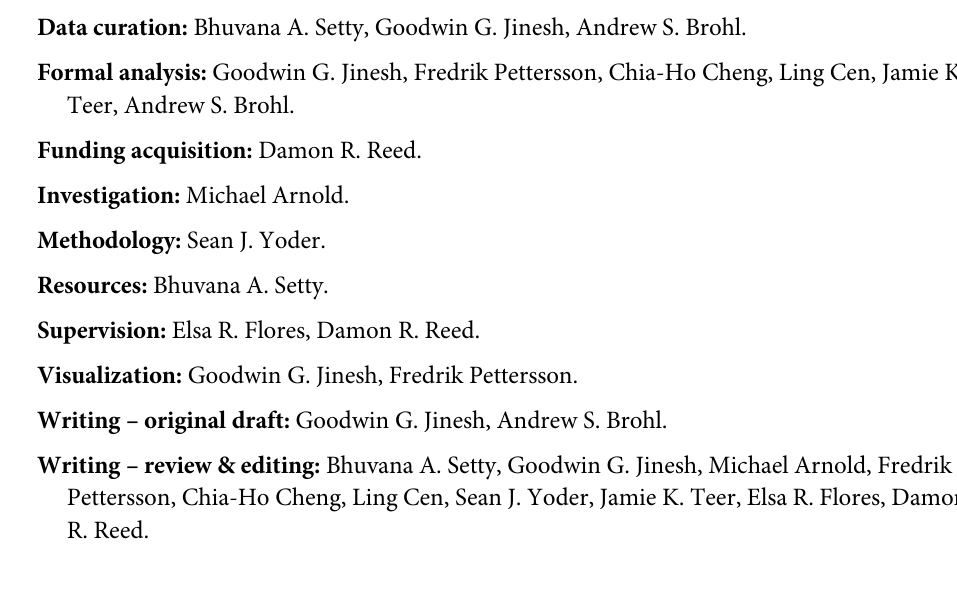
S2 Fig. Proposed multistep genomic development of UESL. C19MC overexpression due to chromosomal structural event and TP53 mutations are the genomic hallmarks of UESL. S1 Table. miRNAs that form C19MC correlatively expressed set-1 and 2 and the list of TP53 and K-Ras regulatory miRNAs that are negatively correlated to C19MC miRNAs. S2 Table. Putatively oncogenic somatic mutations in matched tumor-normal sequencing cohort. S3 Table. EnrichR p-value based ranking of gene sets associated with UESL RNA-seq data-